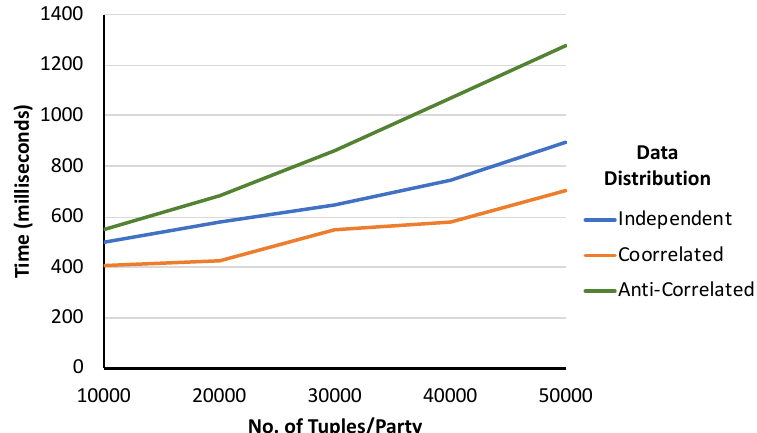
Figure 5. Running time varies with data distribution. [Dimension: 2; Bit-slice length: 11-bit; Slices/Attribute: 3].